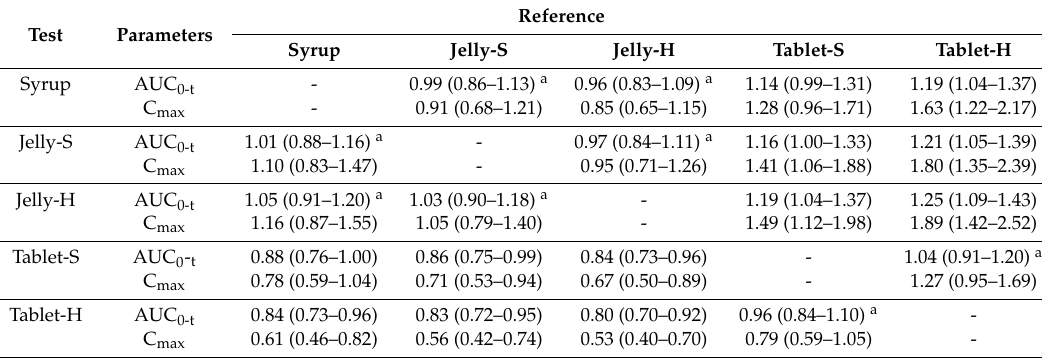
Table 5. Point estimates of mean ratio (90% confidence intervals) for AAP.